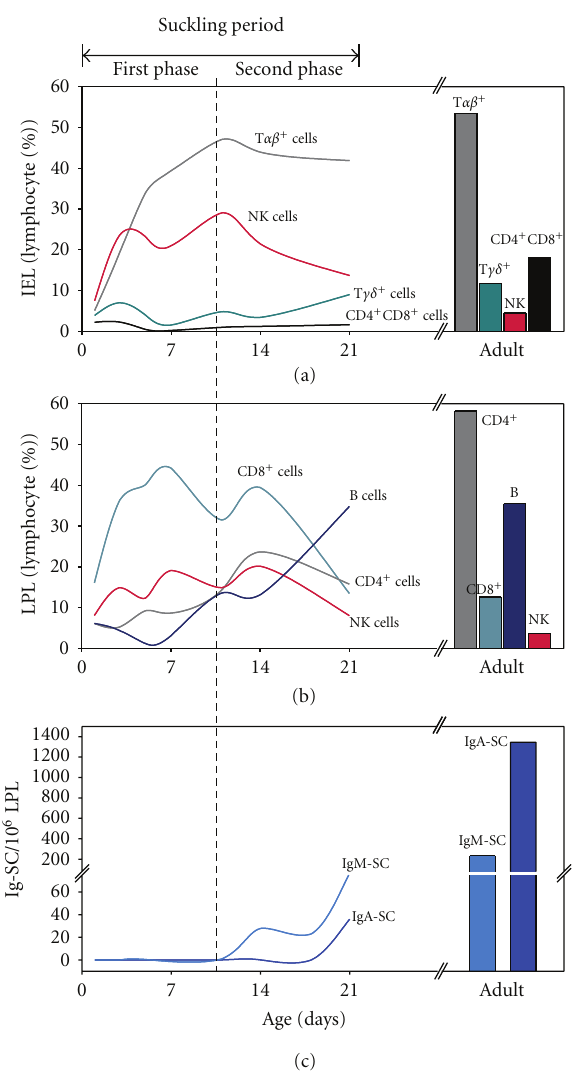
Figure 2: Pattern of maturation of the main e ff ector lymphocyte populations in the rat small intestine during suckling. Results were estimated from data obtained from 1, 3, 5, 7, 11, 14, and 21-day-old rats. (a) Relative proportions of intraepithelial lymphocytes (IELs) in suckling and adult Lewis rats. Intestinal IEL suspensions were obtained by incubations with DTT, EDTA and medium, and subsequent purification with 44/67.5% Percoll. Immunofluorescence staining with anti-rat antibodies to CD4, CD8 α , TCR αβ , TCR γδ , and NKR-P1A was then applied. Flow cytometry analysis allowed establishing the percentage of a particular IEL subset with respect to the total number of IEL [30]. (b) Relative proportions of lamina propria lymphocytes (LPLs) in suckling and adult Lewis rats. LPLs suspensions were obtained after removing IELs, by digestion with collagenase, and purified with 44/67.5% Percoll. LPL were then stained with fluorescence-conjugated antibodies to CD4, CD8 α , CD45RA, and NKR-P1A. Analyses were performed by flow cytometry and cells were expressed as the percentage of positive cells with respect to total LPL [31]. (c) Number of IgM- and IgA-secreting cells (SC) in 10 6 cells from small intestine lamina propria in suckling and adult Lewis rats. LPL suspensions were obtained after removing IELs by digestion with collagenase-dispase. Thereafter, serial dilutions of LPL were incubated in anti-rat IgM or IgA-coated plates. Biotin-conjugated anti-rat IgA or IgM, extravidin-peroxidase and colorimetric substrate allowed enumerating spots that corresponded to each secreting cell